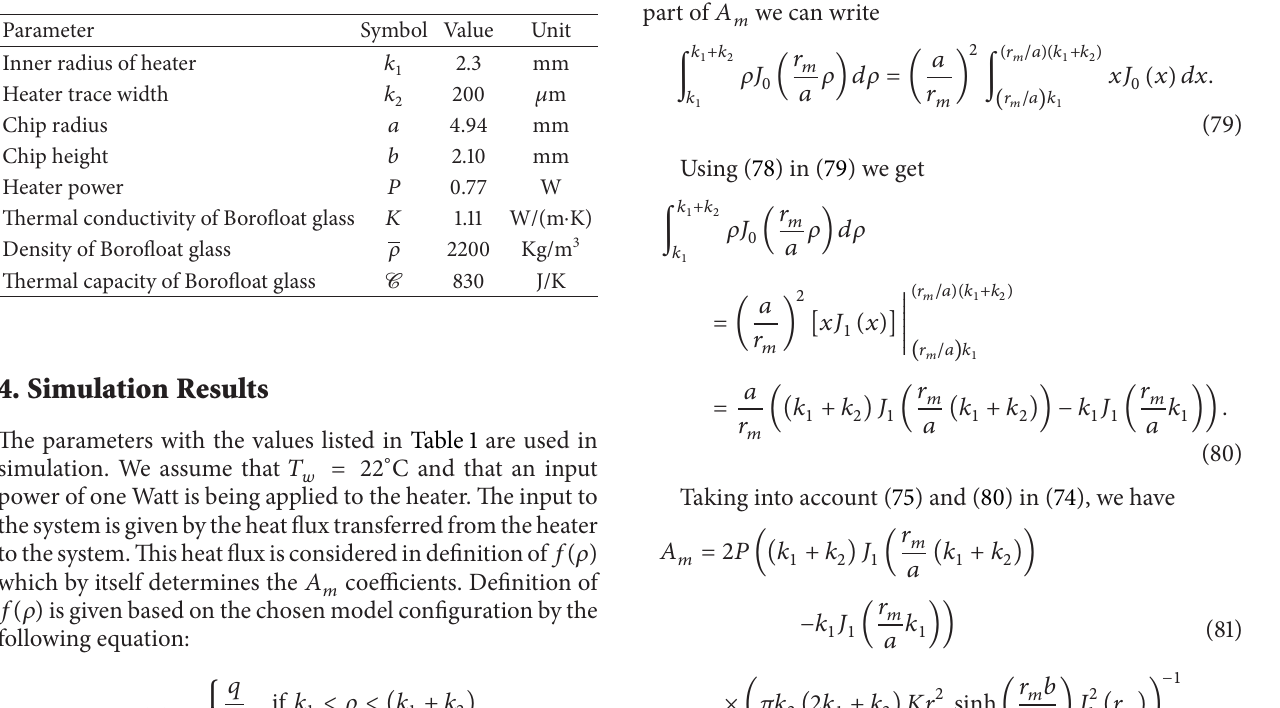
Table 1: Parameter values of PCR-LOC chip